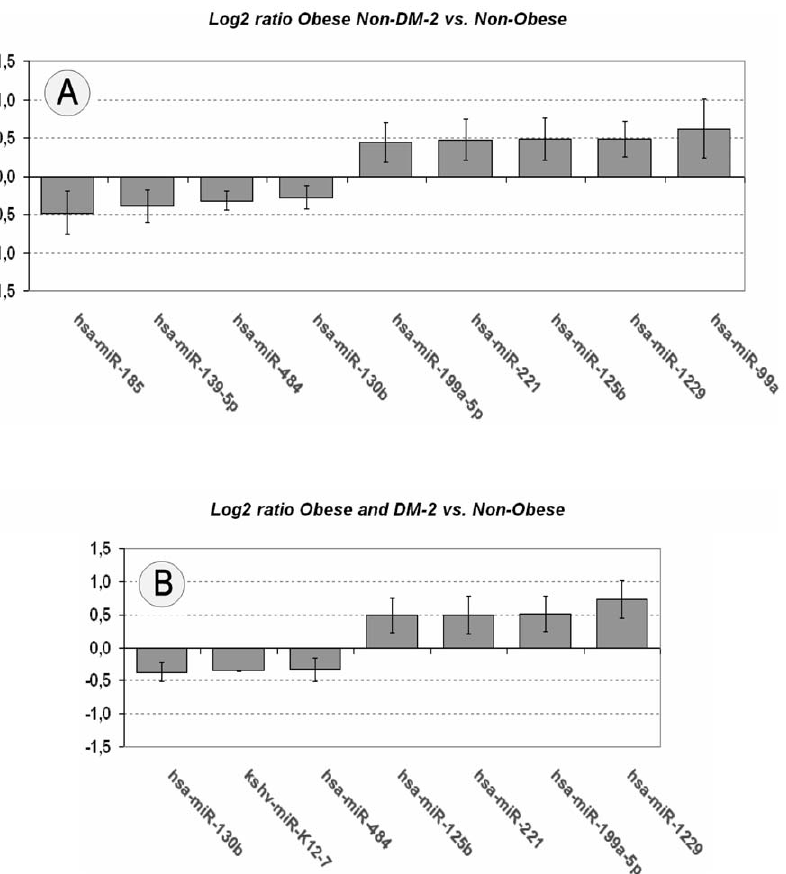
Figure 4. Human subcutaneous miRNAs expressions. Expressions of miRNAs are normalized to an internal control and plotted as fold-changes in a Log2-scale for obese non-DM-2 vs. non-obese (Fig. A) or obese and DM-2 vs. non-obese (Fig. B). Data are expressed as mean 6 SEM. The represented miRNAs showed in each case ANOVA P -values , 0.05 for comparisons between groups and fold-changes over 1.2-fold or under 2 1.2-fold subcutaneous fat from non-obese miRNA level.